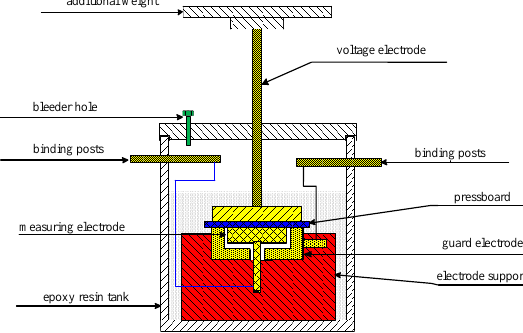
Figure 1. Schematic diagram of the three-electrode test cell.